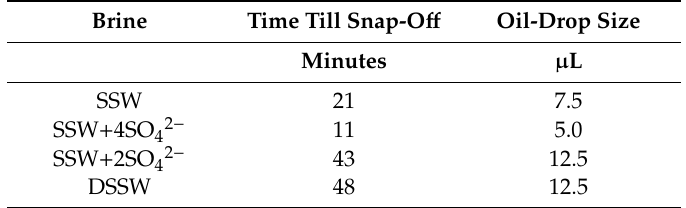
Figure 5. Oil-drop volume increase until snap-off point in SSW+2SO 4 −2 brine (Indirect interfacial viscoelastic response). Table 8. Oil-drop size analysis before snap-o ff